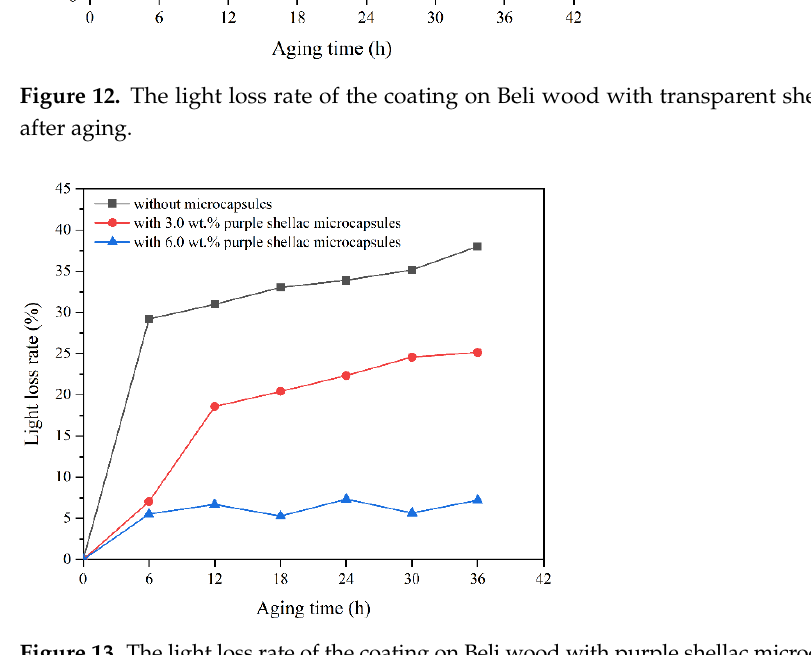
Figure 13. The light loss rate of the coating on Beli wood with purple shellac microcapsules after aging.